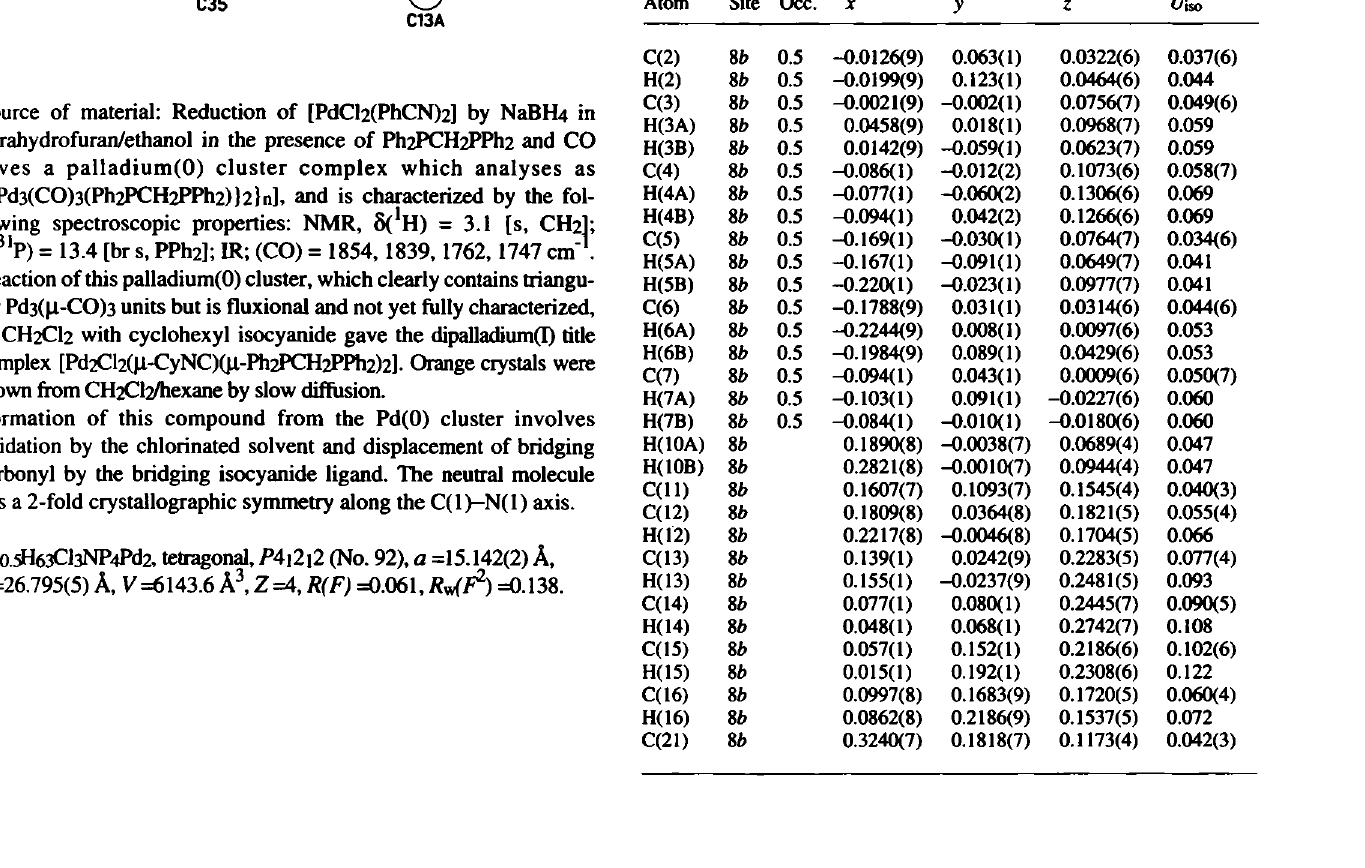
Table 2. Final atomic coordinates and displacement parameters (in Â 2